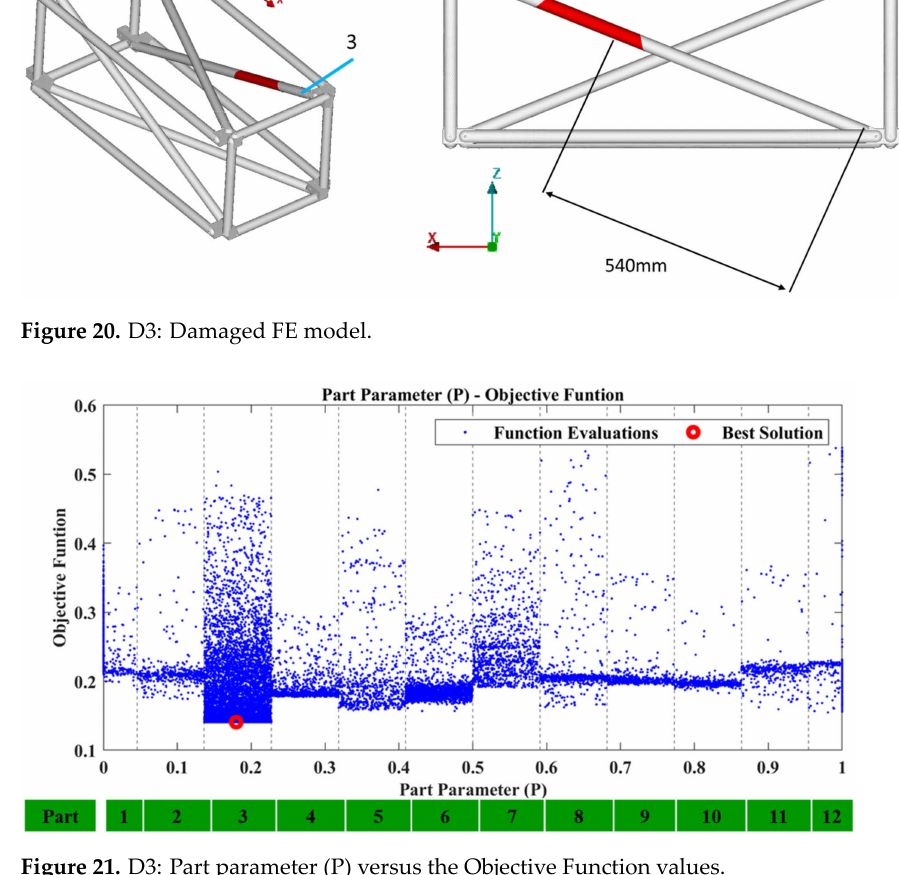
Figure 21. D3: Part parameter (P) versus the Objective Function